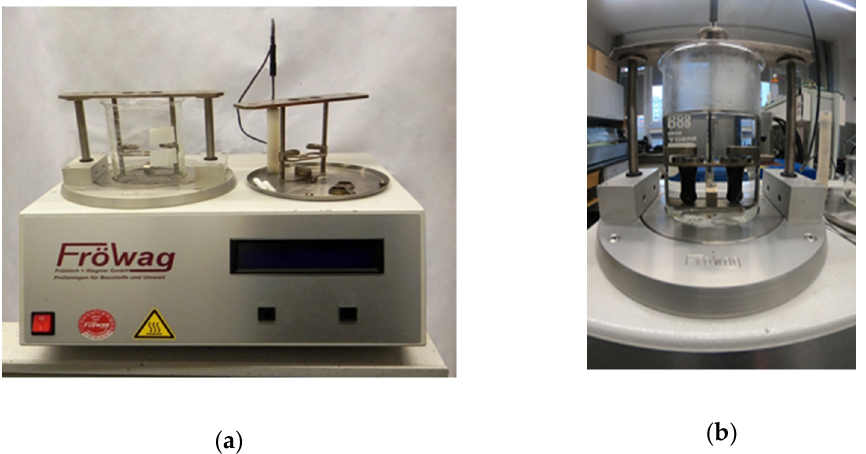
Figure 6. Automatic device for measuring bitumen softening point ( a ), bitumen specimen during testing ( b ) (photo by M. M. Iwa ń ski).